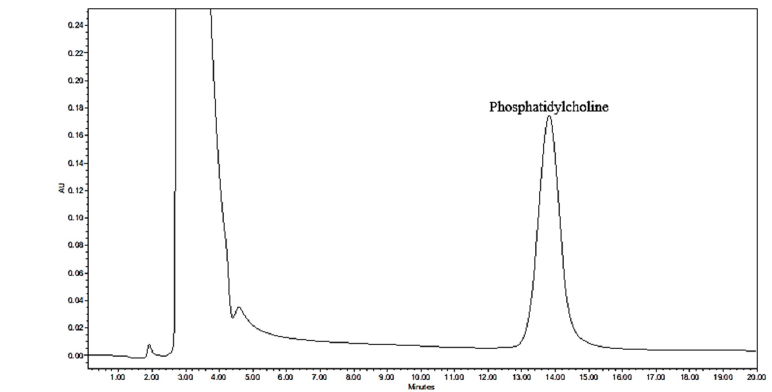
Figure 1. HPLC chromatogram depicting the resolution of phosphatidylcholine standard at 14.1